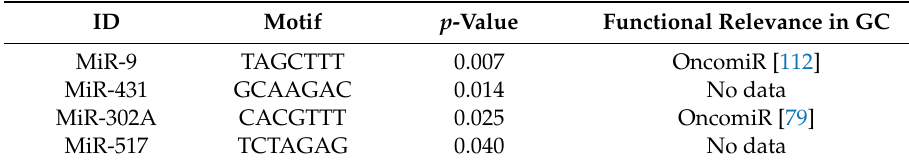
Table 4. List of upregulated miRNAs in gastric cancer stem cells. p -value < 0.05 was considered as statistically